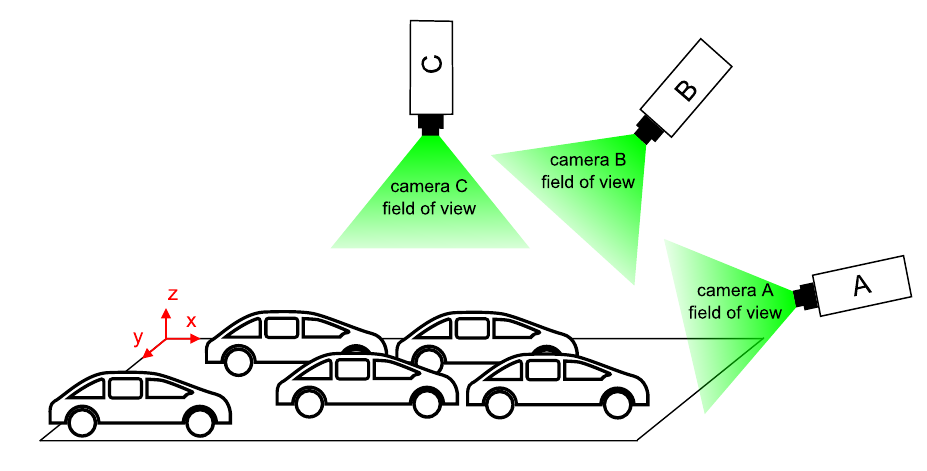
Figure 2. Possible camera